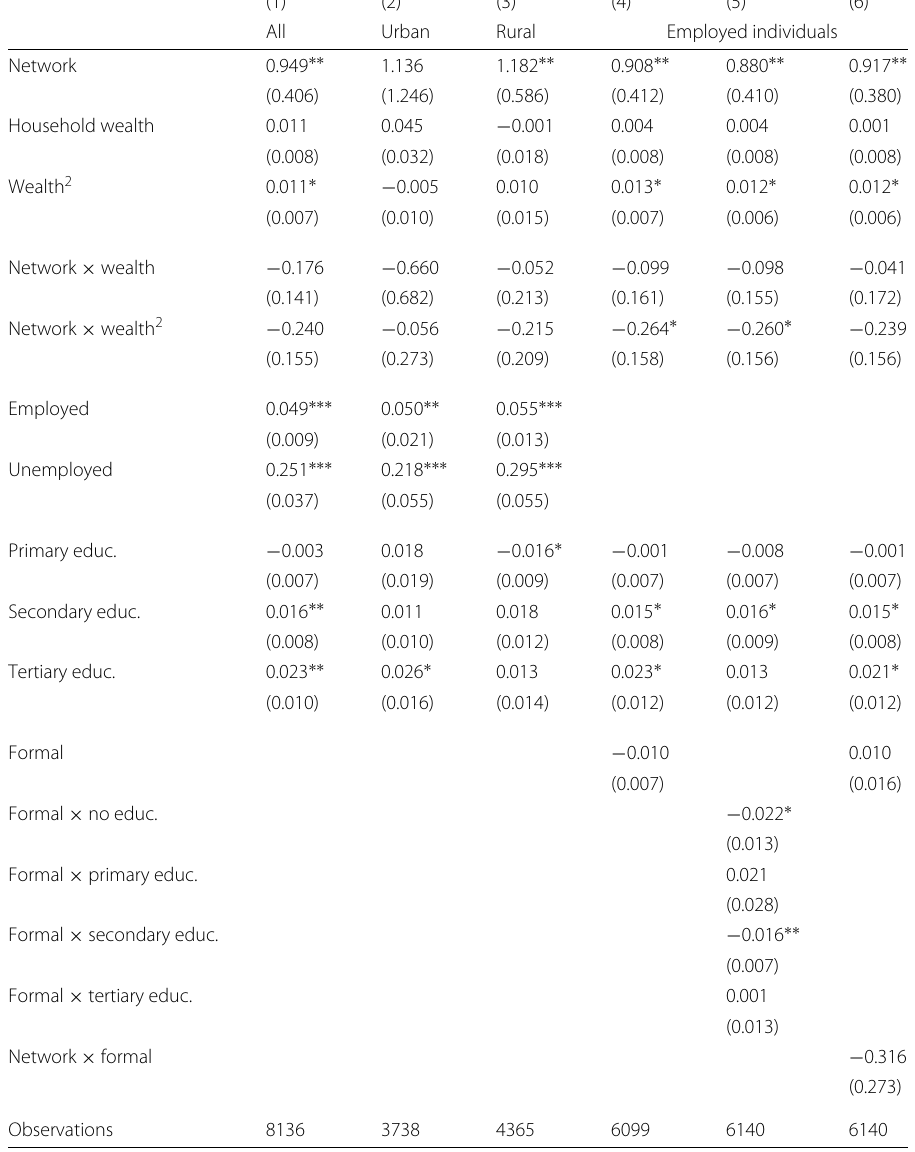
Table 14 Individual determinants of emigration: labor market factors, IV results (1) (2) (3) (4) (5) (6) All Urban Rural Employed individuals Network 0.949 ∗∗ 1.136 1.182 ∗∗ 0.908 ∗∗ 0.880 ∗∗ 0.917 ∗∗ (0.406) (1.246) (0.586) (0.412) (0.410) (0.380) Household wealth 0.011 0.045 − 0.001 0.004 0.004 0.001 (0.008) (0.032) (0.018) (0.008) (0.008) (0.008) Wealth 2 0.011 ∗ − 0.005 0.010 0.013 ∗ 0.012 ∗ 0.012 ∗ (0.007) (0.010) (0.015) (0.007) (0.006) (0.006) Network × wealth − 0.176 − 0.660 − 0.052 − 0.099 − 0.098 − 0.041 (0.141) (0.682) (0.213) (0.161) (0.155) (0.172) Network × wealth 2 − 0.240 − 0.056 − 0.215 − 0.264 ∗ − 0.260 ∗ − 0.239 (0.155) (0.273) (0.209) (0.158) (0.156) (0.156) Employed 0.049 ∗∗∗ 0.050 ∗∗ 0.055 ∗∗∗ (0.009) (0.021) (0.013) Unemployed 0.251 ∗∗∗ 0.218 ∗∗∗ 0.295 ∗∗∗ (0.037) (0.055) (0.055) Primary educ. − 0.003 0.018 − 0.016 ∗ − 0.001 − 0.008 − 0.001 (0.007) (0.019) (0.009) (0.007) (0.007) (0.007) Secondary educ. 0.016 ∗∗ 0.011 0.018 0.015 ∗ 0.016 ∗ 0.015 ∗ (0.008) (0.010) (0.012) (0.008) (0.009) (0.008) Tertiary educ. 0.023 ∗∗ 0.026 ∗ 0.013 0.023 ∗ 0.013 0.021 ∗ (0.010) (0.016) (0.014) (0.012) (0.012) (0.012) Formal − 0.010 0.010 (0.007) (0.016) Formal × no educ. − 0.022 ∗ (0.013) Formal × primary educ. 0.021 (0.028) Formal × secondary educ. − 0.016 ∗∗ (0.007) Formal × tertiary educ. 0.001 (0.013) Network × formal − 0.316 (0.273)